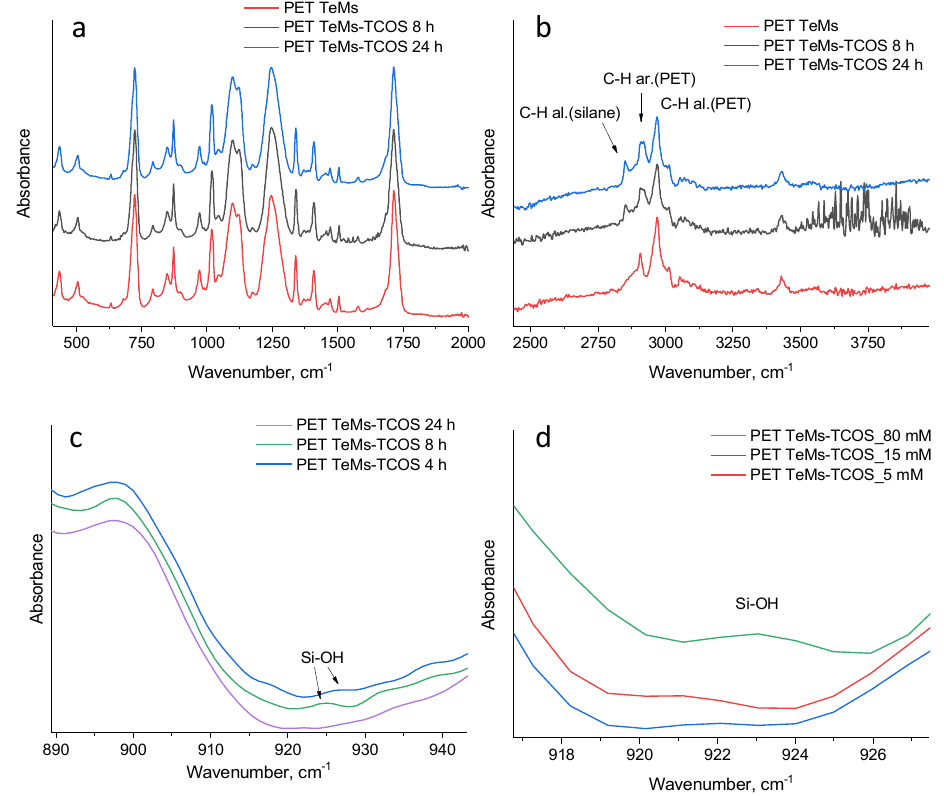
Figure 4. FTIR spectra of the initial and modified PET TeMs depends on time in the range of 400–